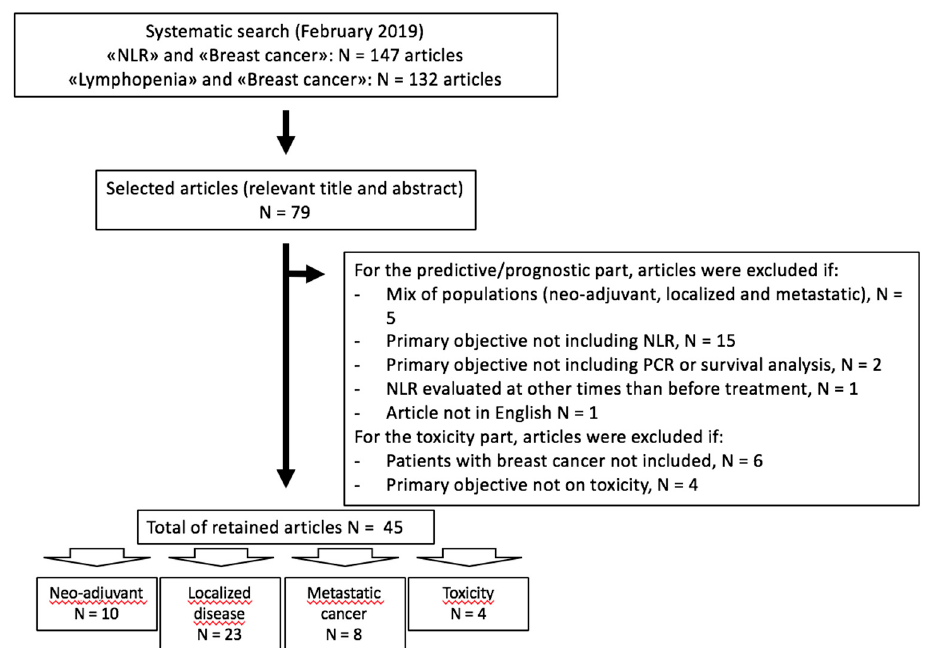
Figure 1. Flow chart of the study selection.